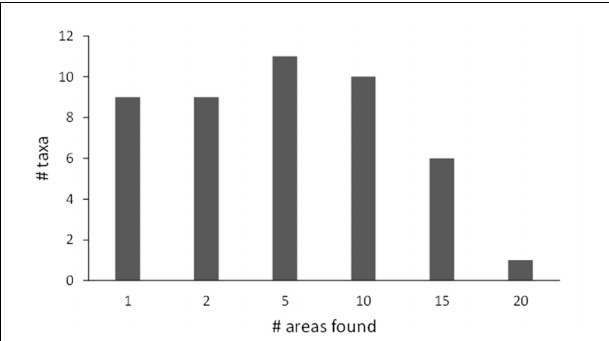
FIGURE 10 | Frequency distribution of the numbers of fish taxa with varying levels of species overlap (# of sites in which each was found out of 28 sites that had identified fish) across the Pacific from both camera transect and baited camera